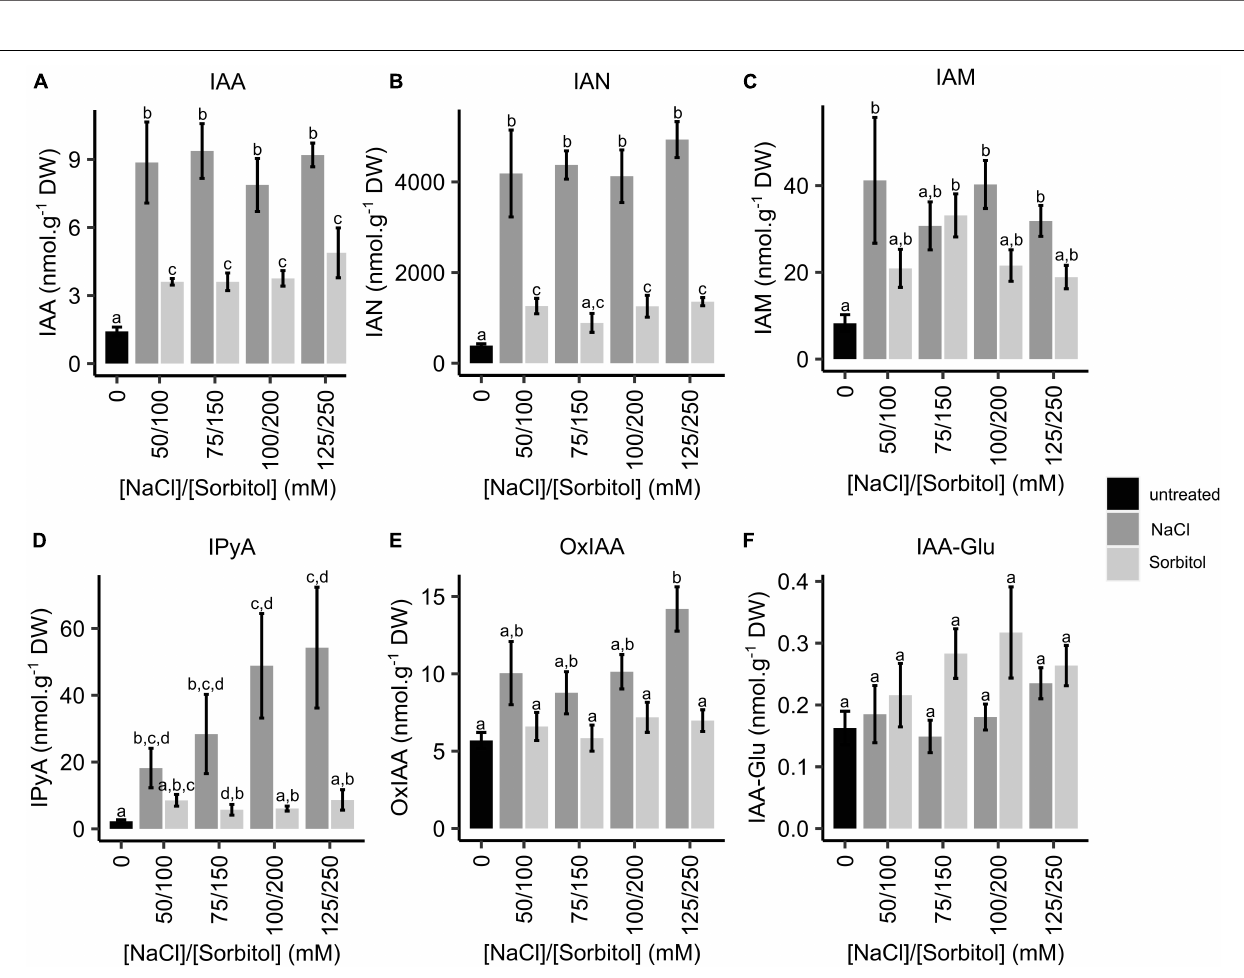
FIGURE 5 | Quantification of IAA, IAA biosynthetic intermediates and IAA oxidation and conjugation products in Arabidopsis plants grown on NaCl and sorbitol. Arabidopsis Col-0 was germinated and grown for two weeks in petri dishes containing ATS media (0 mM, untreated control) and ATS supplemented with the indicated concentrations of NaCl and sorbitol. LC-MS/MS was used to quantify IAA (A) , IAN (B) , IAM (C) , IPyA (D) , oxIAA (E) and IAA-Glu (F) . The black bar represents the untreated control, dark grey bars represent NaCl treatments and light grey bars represent sorbitol treatments. The results are the mean of five biological repeats. Error bars represent standard error. Different letters on the graphs indicate statistically significant differences ( p ≤ 0.05) in metabolite concentration (nmol.g − 1 DW) as determined by one way ANOVA followed by Fisher LSD post-hoc analysis. IAA : indole-3-acetic acid, IAN : indole-3-acetonitrile, IAM : indole-3-acetamide, IPyA : indole-3-pyruvic acid, oxIAA : oxidised IAA, IAA-Glu : glutamate irreversibly conjugated to